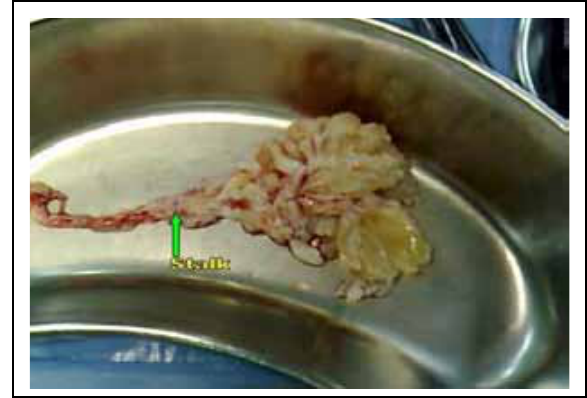
Figure 1. the tumor after excision. the larger end presented as a right atrial mass.